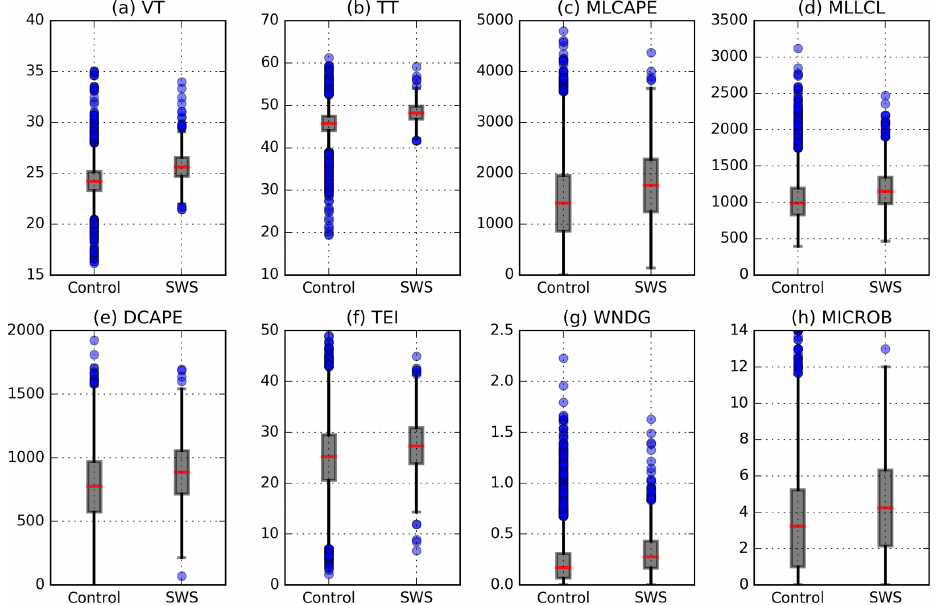
Figure 5. Box plots of selected convective parameters that demonstrated skill in differentiating between the control days and SWS days.